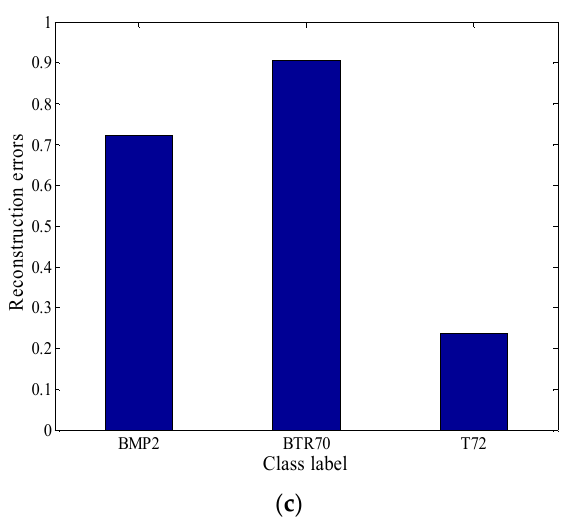
Figure 9. ( a ) BMP2 reconstruction errors of ALADPL. ( b ) BTR70 reconstruction errors of ALADPL. ( c ) T72 reconstruction errors of ALADPL.